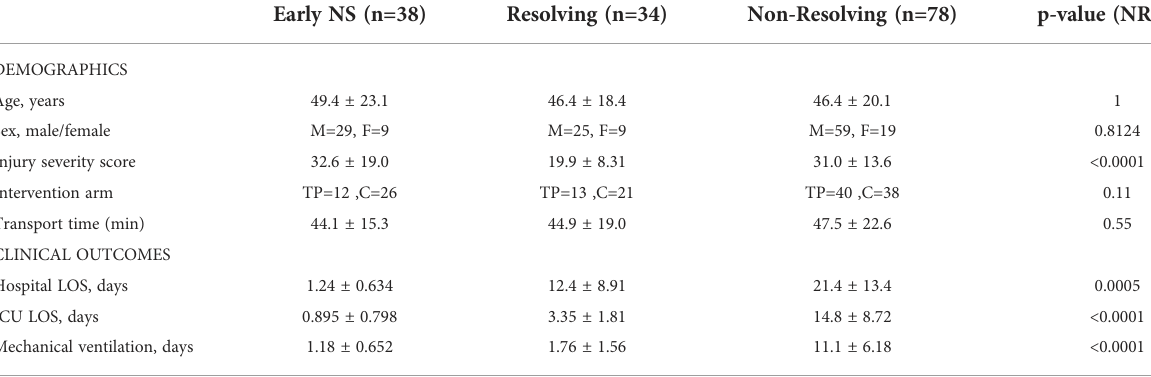
TABLE 1 Demographic data and clinical outcomes of patient